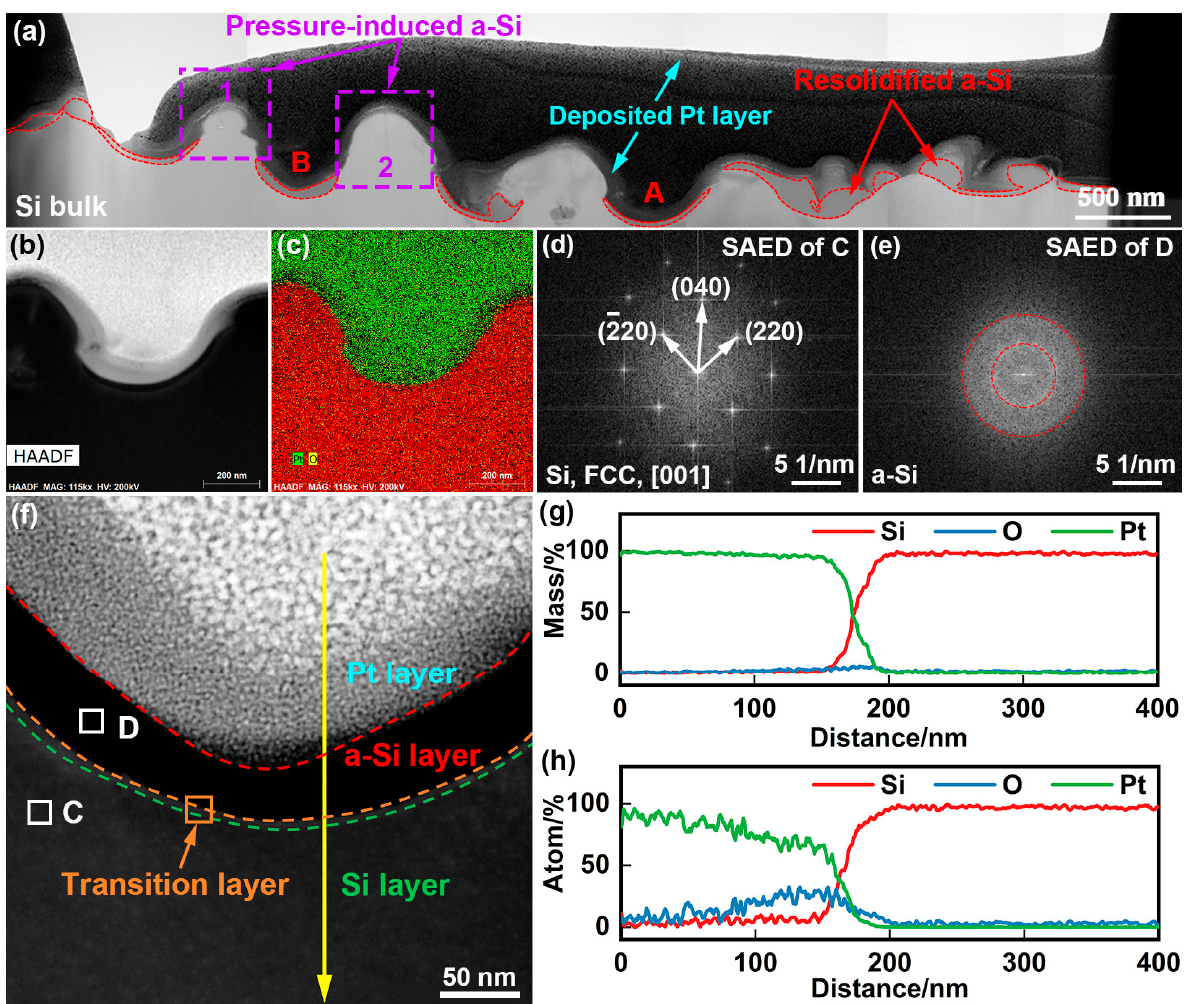
Figure 5. TEM analysis of the LIPSS. ( a ) TEM bright-field image (red dashed lines indicate the a-Si region), numbers 1 and 2 represent regions of interest in Figure 7; ( b ) HAADF image of the region A in ( a ); ( c ) superposition of Si, O, and Pt elements; ( g ) HAADF image of region B in ( a ); ( d , e ) SAED patterns of regions C and D in ( f ); ( g , h ) EDS line scan analysis of the yellow line in ( f ).